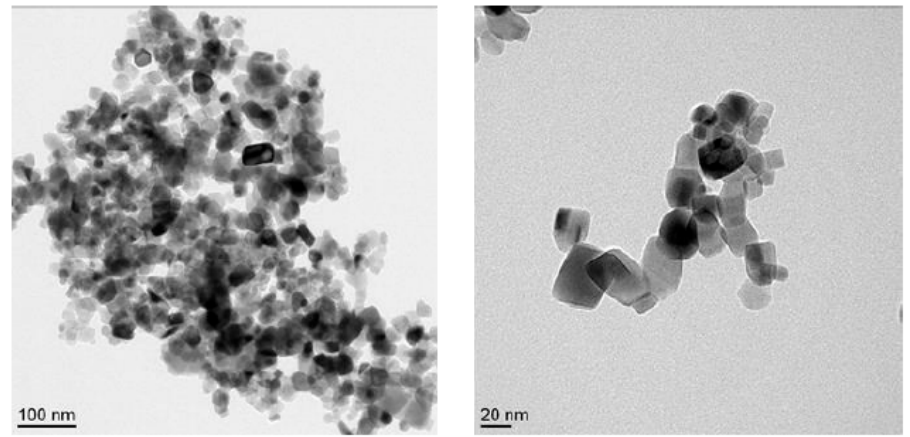
Figure 1. TEM images of titanium dioxide nanoparticles. TiO 2 NPs (NM-105) in anatase dominant form. Table 1. TiO 2 NP characteristics.